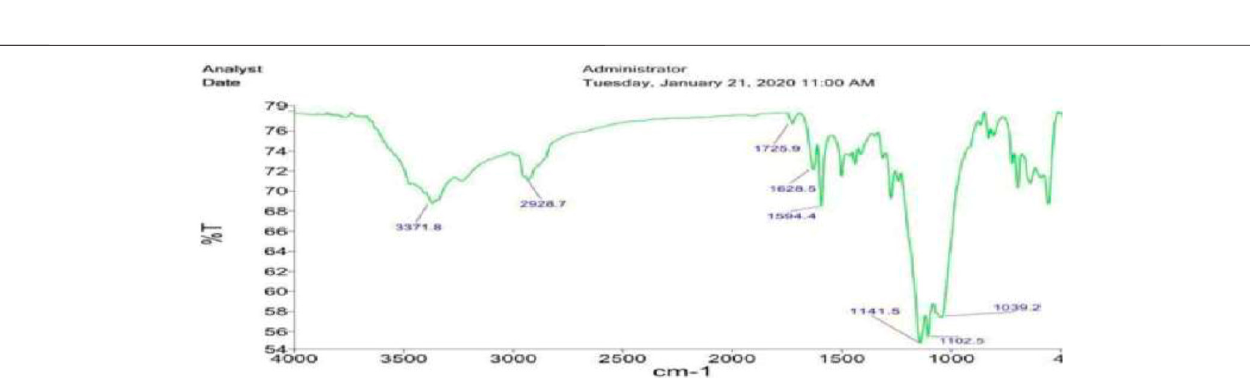
Frontiers in Chemistry |